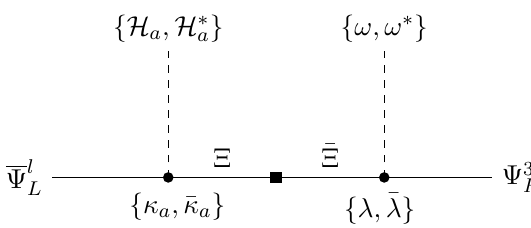
Figure 5 . Feynman diagrams, depicted in the unbroken G 12 × G 3 phase, that lead to mixing between the third family and light family fermions. Integrating out the VLF Ξ and expanding the scalar field ω about its vev gives the relevant effective Yukawa couplings mixing the light families with the third. The notation ‘ { κ, ¯ κ } ’ denotes, for example, that there are two possible couplings that can feature, connecting to either H or its conjugate H ∗ . Recall from section 2.3 that the bar a denotes an independent